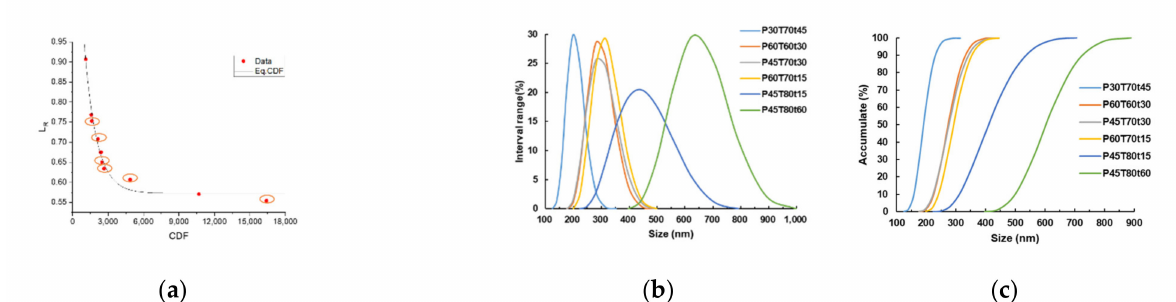
Figure 5. Size measurements of lignin: ( a ) The position of lignin obtained by p -TsOH fractionation on the CDF curve; ( b ) Distribution diagram of lignin particle size interval; ( c ) The cumulative distribution diagram of lignin particle